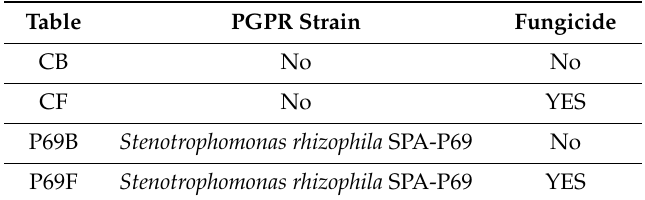
XL:Captan:Korit in a 1:1:0.6 ratio.